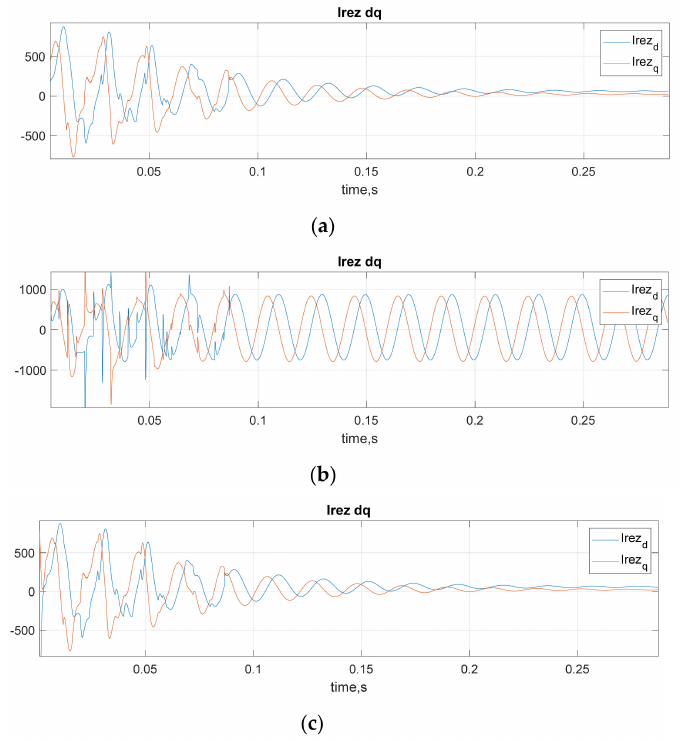
Figure 25. Fading of I rez current of the grid angular frequency filter of the rotor voltage V r : ( a ) type a protection is applied; ( b ) type b protection is applied; ( c ) type c protection is